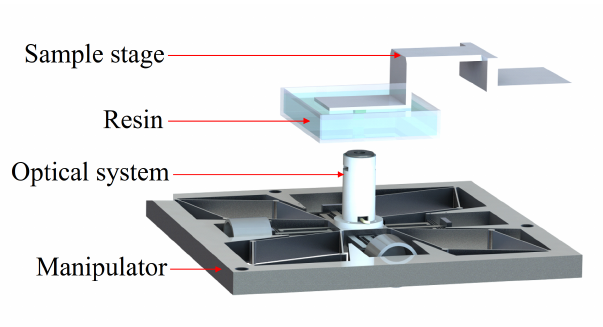
Figure 1. Schematics of the micro-stereolithography (MSL) system based on the fixed-surface method.